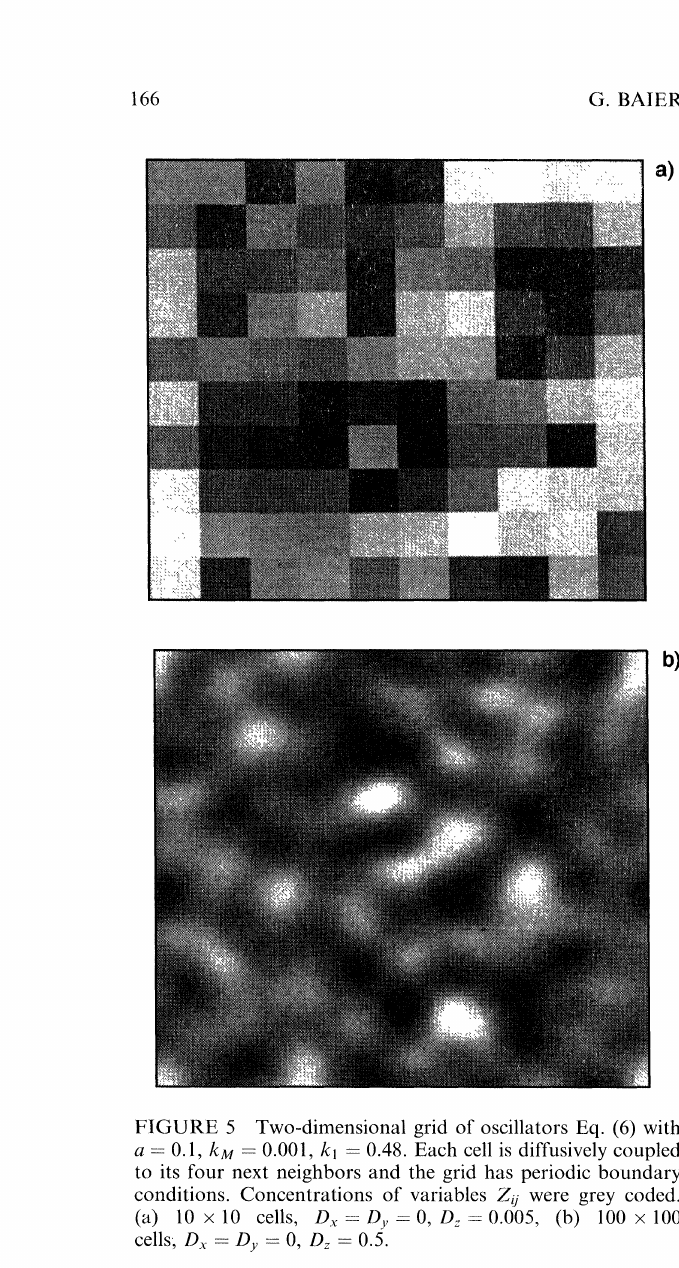
FIGURE 5 Two-dimensional grid of oscillators Eq. (6) with a 0.1, k4 0.001, kl 0.48. Each cell is diffusively coupled to its four next neighbors and the grid has periodic boundary conditions. Concentrations of variables Z!i were grey coded. (a) 10 x10 cells, Dx=D,=O, D=0.005, (b) 100 xl00 cells; Dx Dy 0, Dz